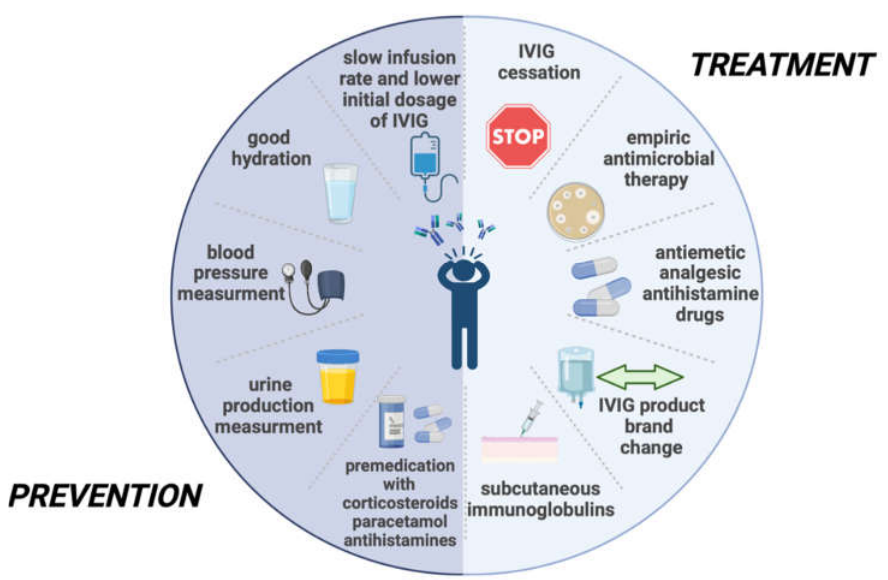
Figure 2. Treatment and preventative measures of IVIG-induced aseptic meningitis [18,30,41,50,52,62,65–67,70,71]. This figure was created with BioRender.com (https://biorender.com/ (accessed on 12 May 2022).